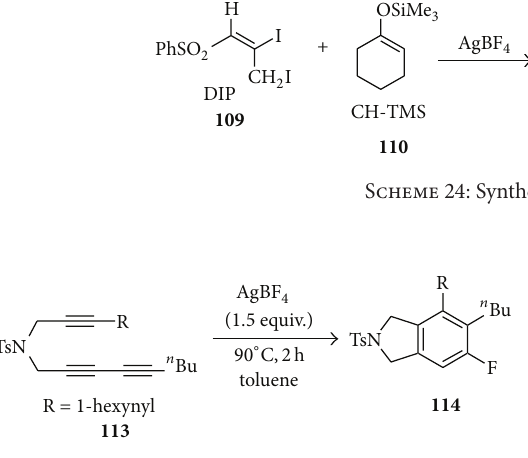
Scheme 25: Synthesis of compound 114 .